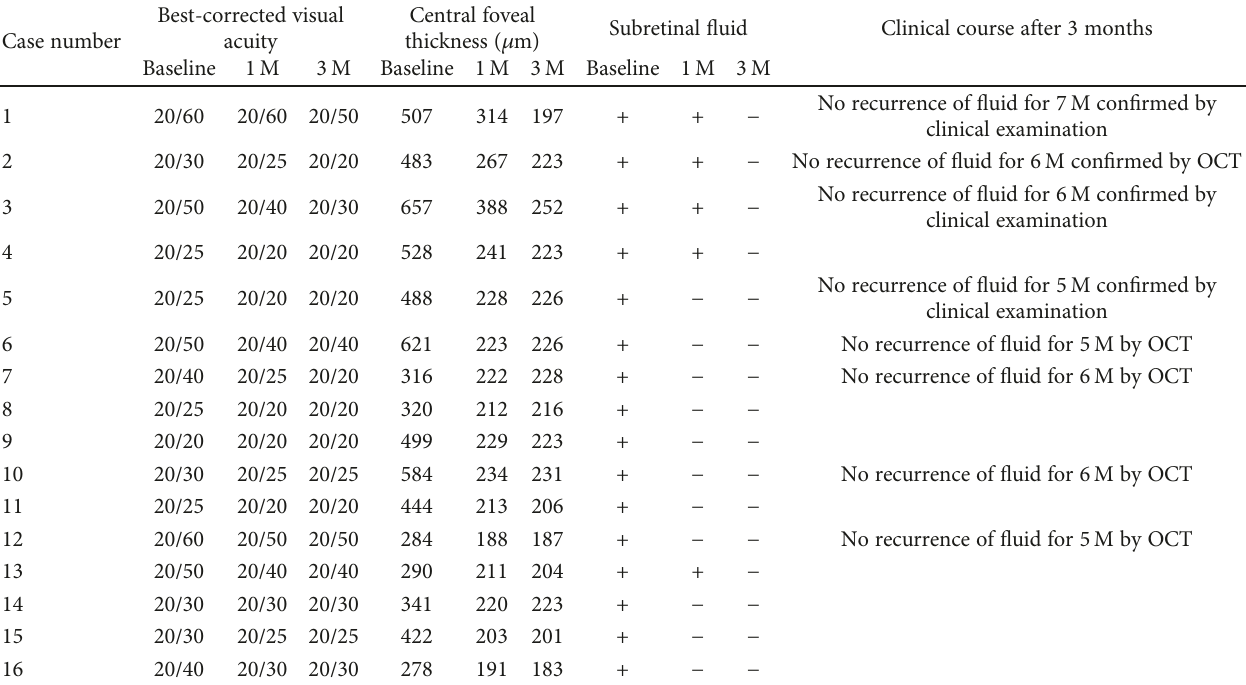
Table 2: Treatment outcomes for 16 included patients.